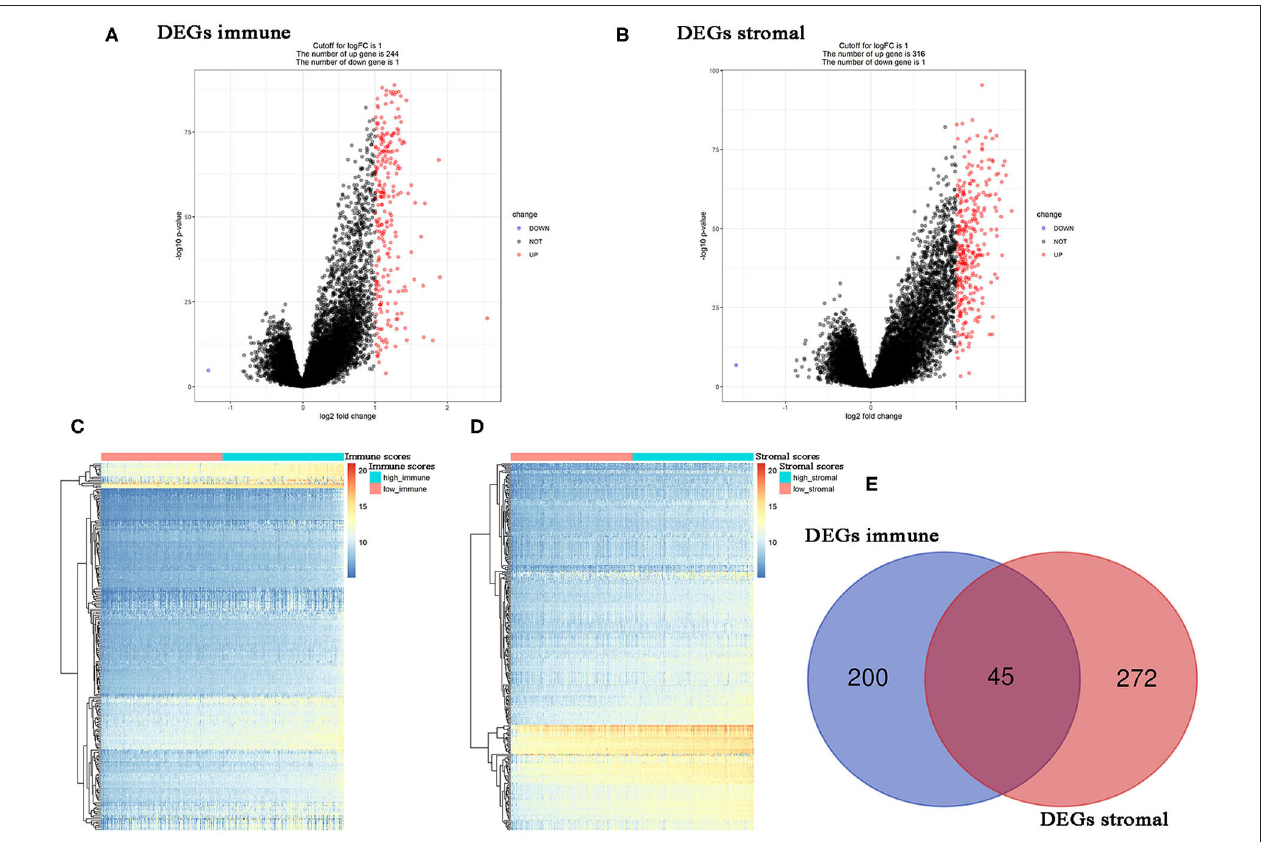
FIGURE 3 | Differentially expressed genes (DEGs) analysis in PC. (A) Volcano plot visualizing the immune-related DEGs. (B) Volcano plot visualizing the stromal-related DEGs. (C) Heatmap of immune scores of high score vs. low score ( P < 0.05, fold change > 1). (D) Heatmap of stromal scores of high score vs. low score ( P < 0.05, fold change > 1). (E) Identification of common DEGs between immune-related DEGs and stromal-related DEGs.